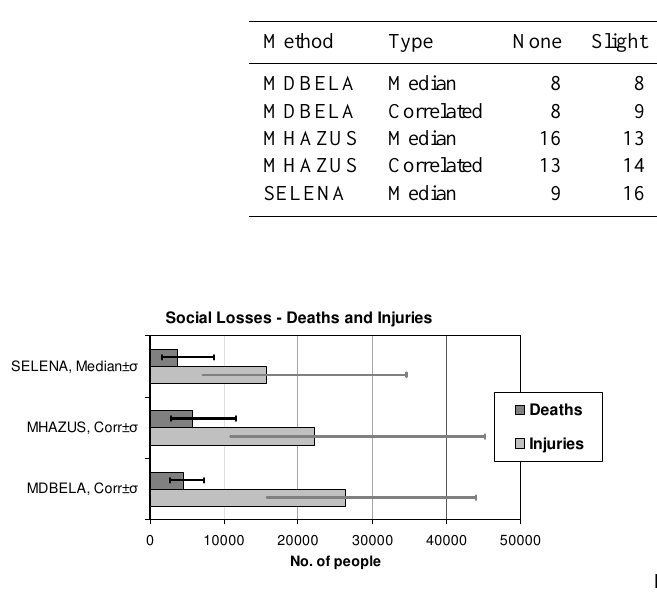
Figure 9. Daytime social losses for the 3 ELE software packages including the 16% and 84% 2 Fig. 9. Daytime social losses for the 3 ELE software packages, (±1 σ ) values from the 100 runs, fitting a lognormal distribution. 3 including the 16% and 84% ( ± 1 σ) values from the 100 runs fitting a lognormal distribution.